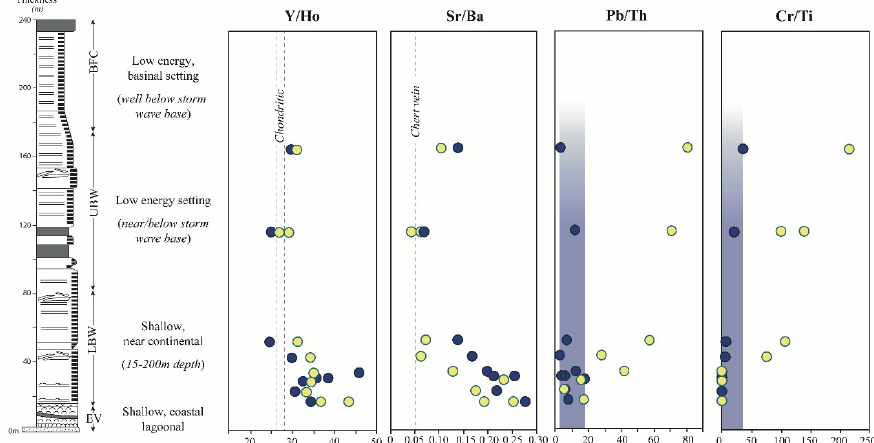
Figure 14. Stratigraphic evolution of some key ratios across the Buck Reef sequence. Stratigraphy on the left is modified from Tice and Lowe [2]. From bottom to top, the results highlight (1) a global decrease of Y/Ho towards chondritic values and a decrease of Sr/Ba ratio; and (2) a decoupling of white chert composition from black cherts, with significant increases in Pb and Cr contents, along with those of Ni, Ba and Co which are not shown. These variations are interpreted as increasing hydrothermal contributions to the ambient chemistry during Buck Reef chert deposition.